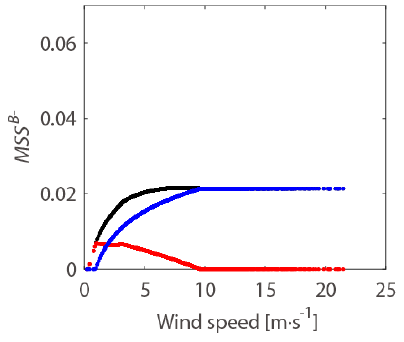
Figure 6. Compensated high-frequency portion of MSS for buoys. The red, blue, and black lines represent the equilibrium range, the saturation range, and the total range, respectively.